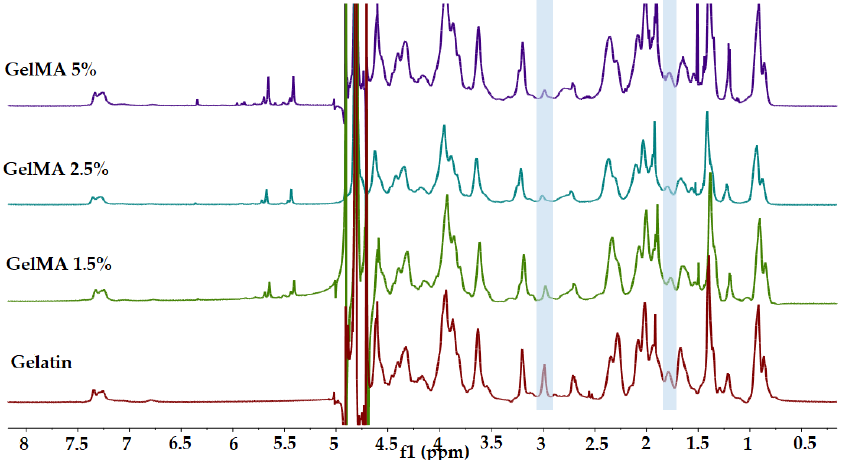
Figure 2. 1 H-NMR spectra of gelatin, GelMA 1.5%, 2.5%, 5%.